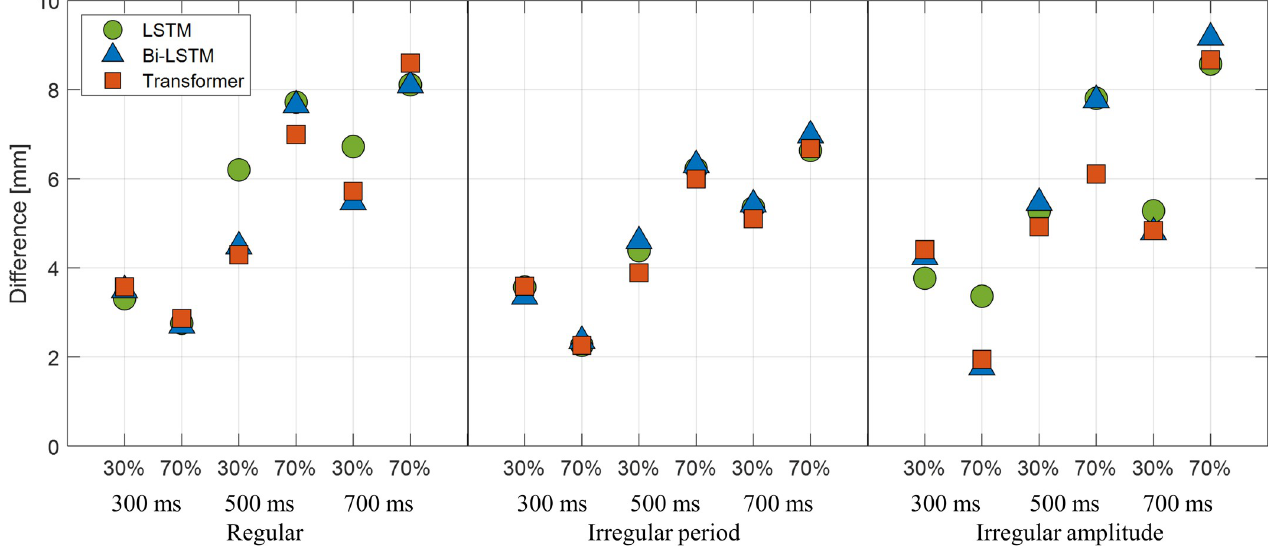
Fig 7. Maximum error results in millimeters. At 30% and 70% phases for regular and irregular patterns with three different prediction points: 300, 500, and 700 ms.